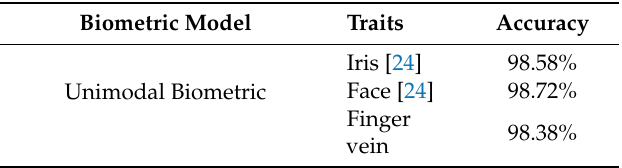
Table 1. Accuracy results using unimodal biometrics systems.